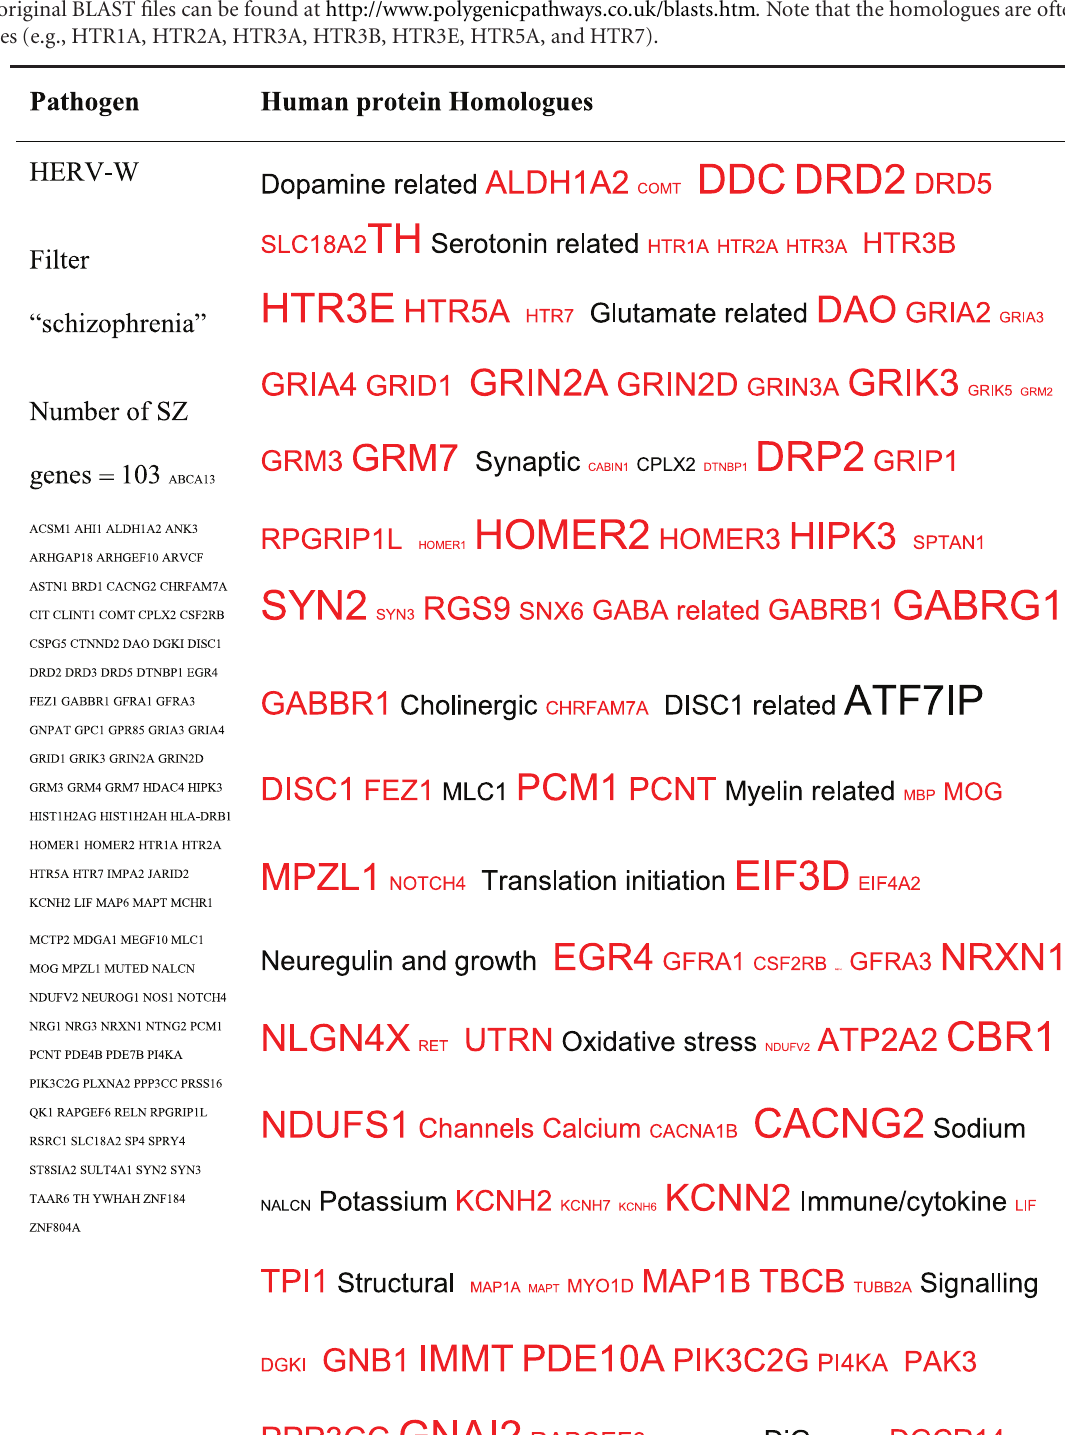
Table 3: Human proteins with homology to proteins expressed by pathogens. The size of the tags reflects the number of pathogen’s proteins that are homologous to the human protein: the filters used are described. The number of schizophrenia susceptibility genes within each of these datasets is shown in the left-hand column. Certain genes are classified according to family and are highlighted in red. Gene definitions and the original BLAST files can be found at http://www.polygenicpathways.co.uk/blasts.htm. Note that the homologues are often